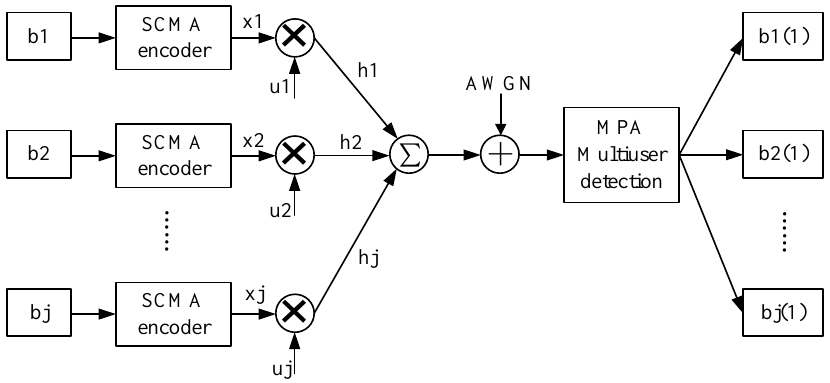
Figure 1. Uplink sparse code multiple access (SCMA) communication system model.